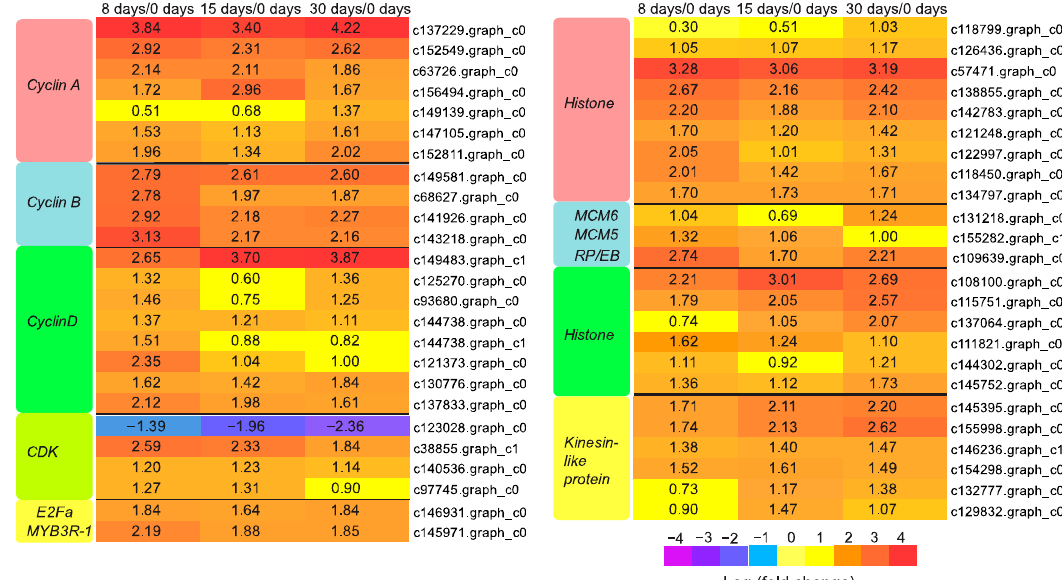
Figure 6. Expression patterns of DEGs involved in and callus formation. The values of log 2 fold change are shown in the heat map.